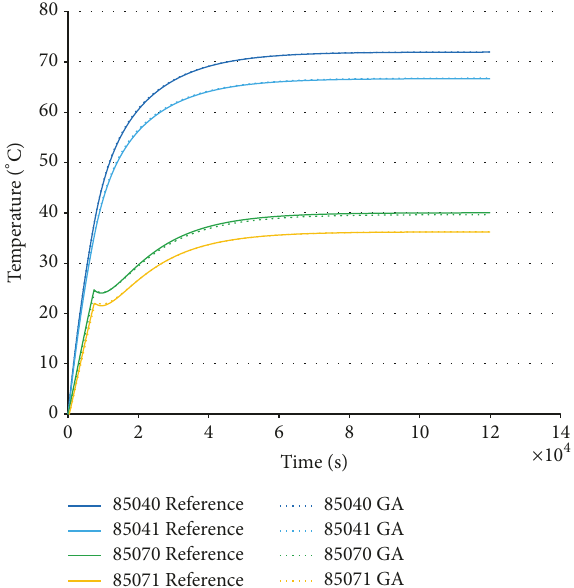
Figure 10: Transient cold case. Temperatures obtained from corre- lations with